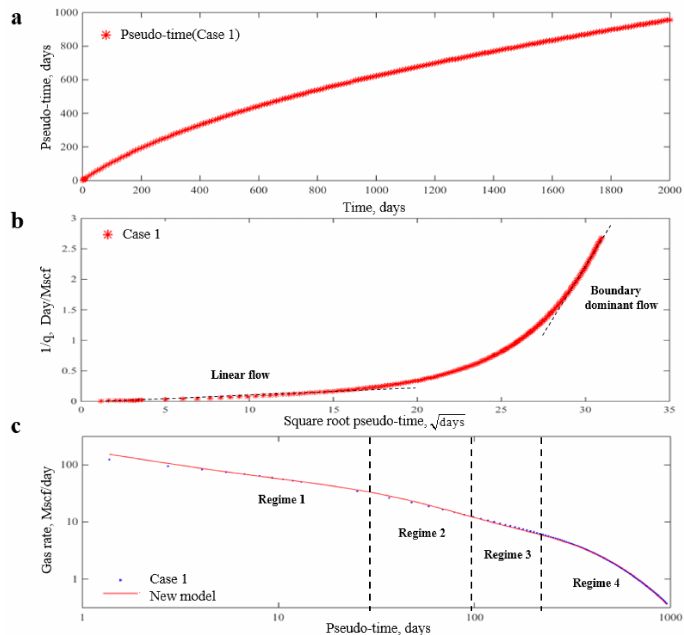
Figure 3. The result analysis for Case 1. ( a ) Comparison of the relationship between pseudo-time and time. ( b ) The plot 1 / q vs. square root pseudo-time for regime diagnosis. ( c ) Comparison of the relationship between gas rate and pseudo-time. (Regime 1: transient linear flow in region 1 with slope -1 / 2. Regime 2: boundary-dominated flow for region 1. Regime 3: transient linear flow in region 2 with slope -1 / 2. Regime 4: boundary-dominated flow for region